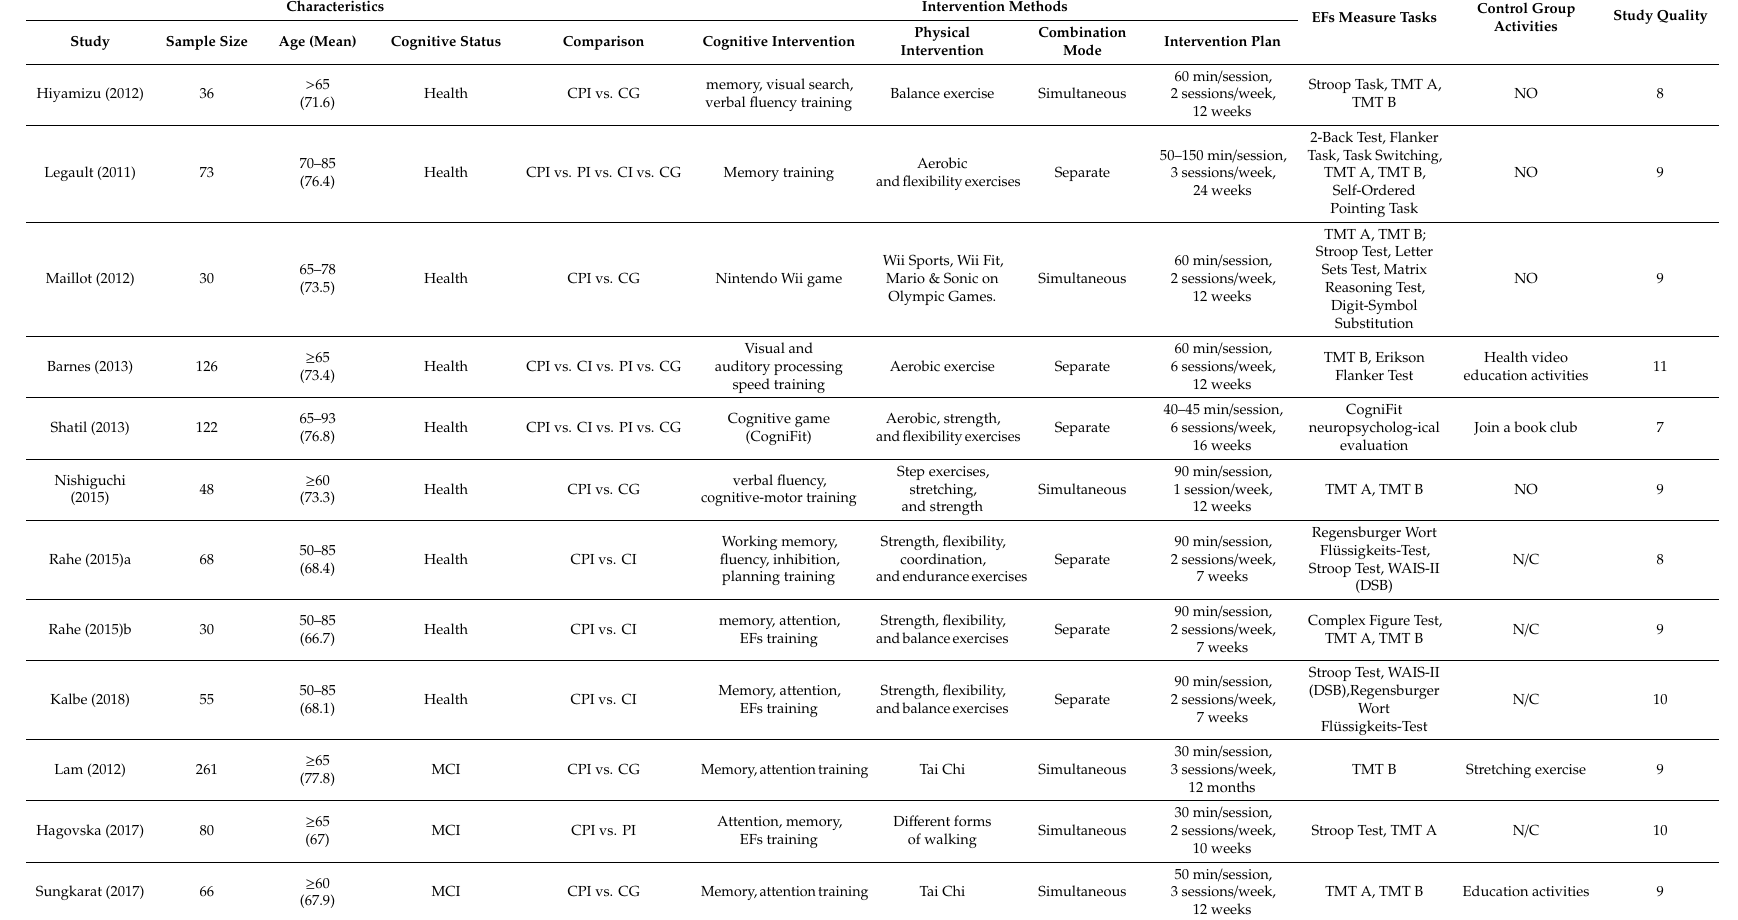
Table 1. Main Characteristics of the Included